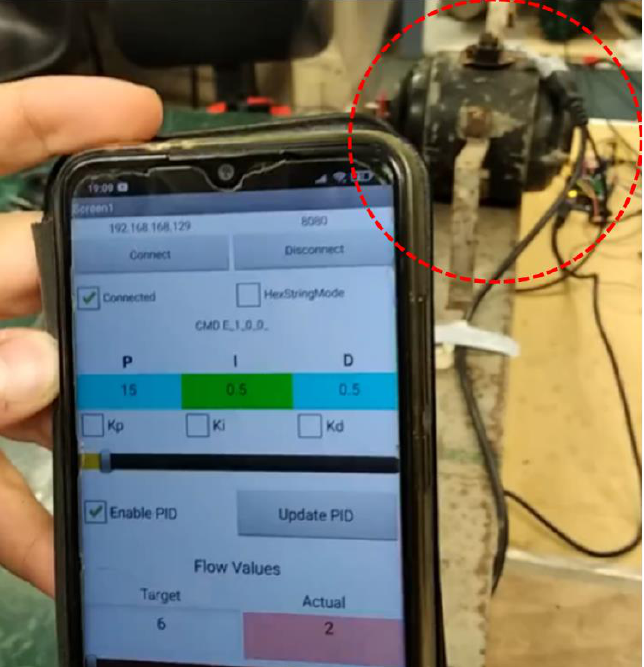
Figure 13. Students’ experimentation with the mobile application for adjusting and monitoring the operation of the ventilation system. Table 1. Detailed inventory of the materials being necessary for basic system’s implementation.